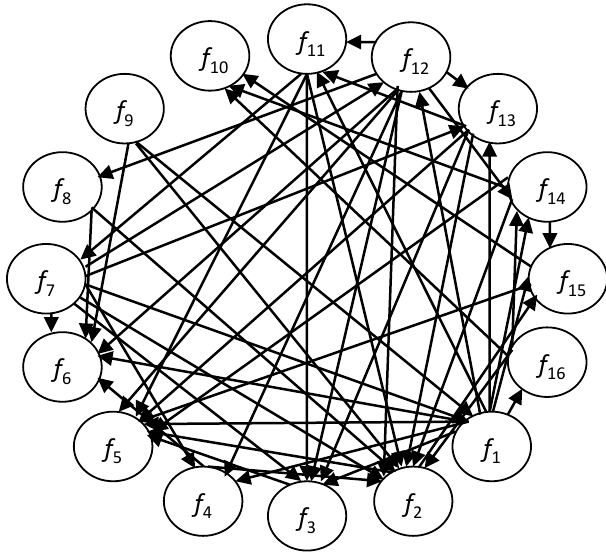
Figure 1. Graph of interrelations between the energy security of the enterprise and the influence